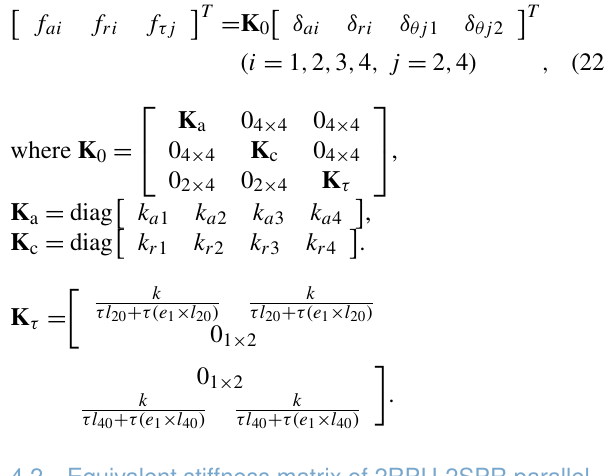
Table 2. Geometric parameters, configuration parameters and phys- ical